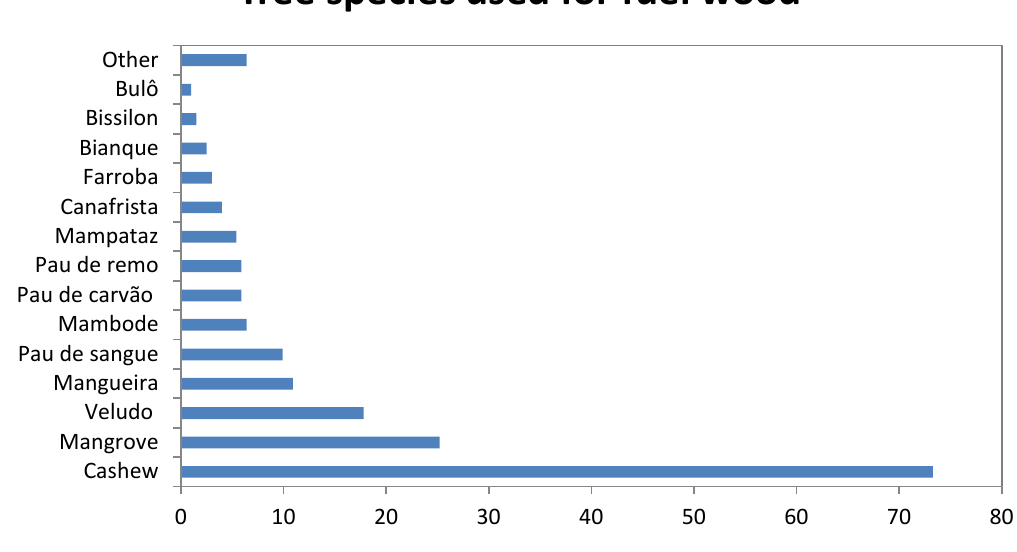
Figure 3. Tree species used for fuel wood: Bulô —Setara pumila ; Bissilon —Khaya senegalensis